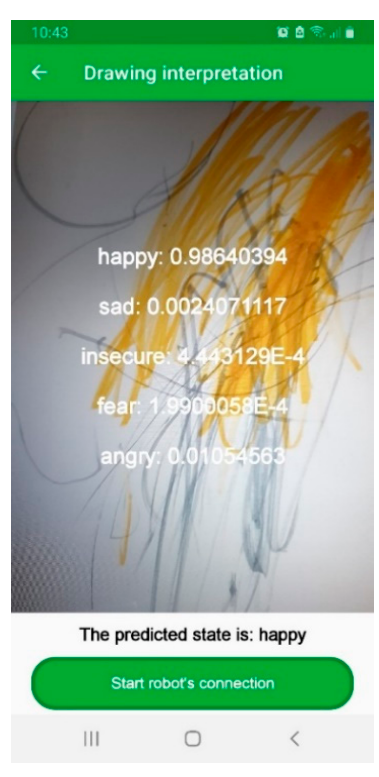
Figure 16. PandaSays drawing interpretation.